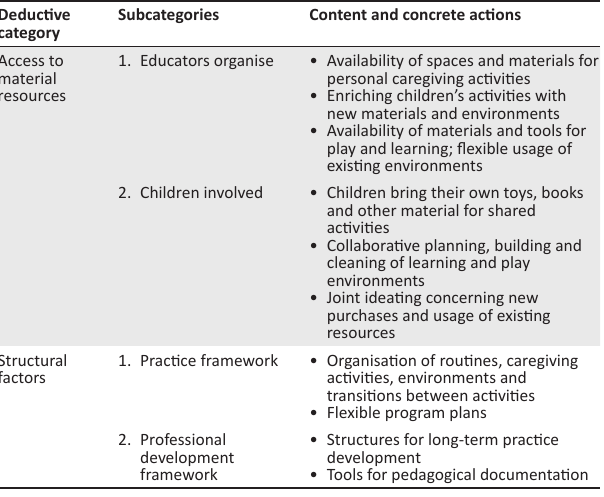
TABLE 3: Access to material resources and structural factors as prerequisites for participation. Deductive category